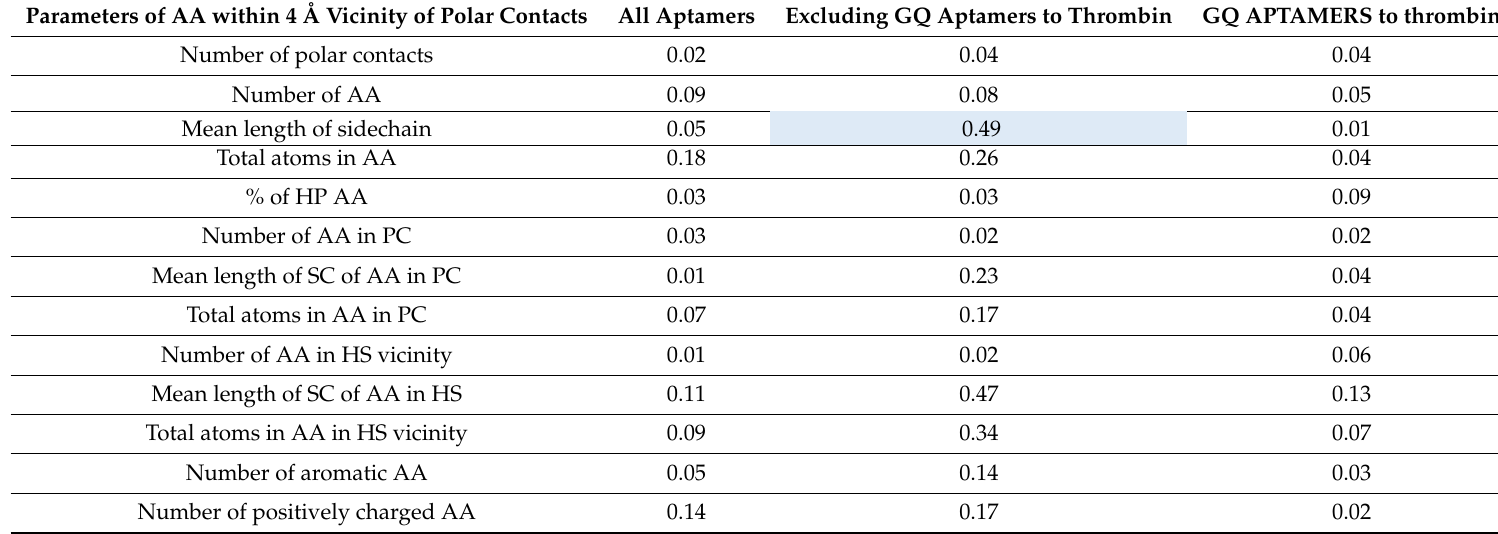
Table 2. Aptamer–protein complexes. The values of coe ffi cient of determination, R 2 , for the linear regression curves for dependencies of di ff erent interface parameters versus changes in Gibbs free energy during binding. The strongest correlation is